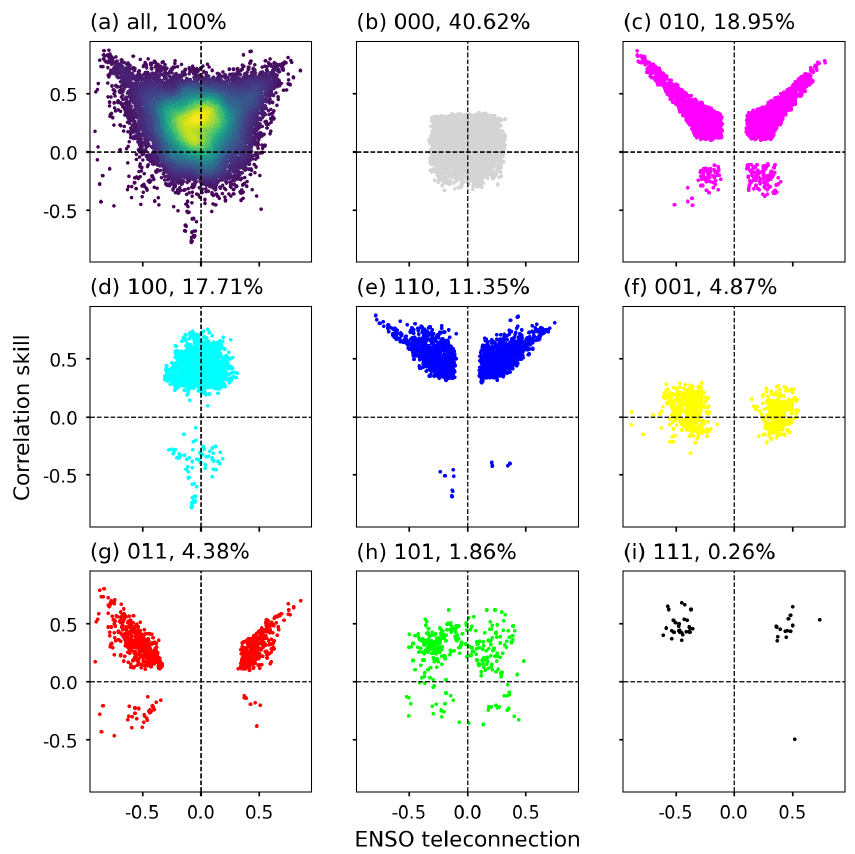
Figure 13. Scatter plots of the association of GCM forecast correlation skill with ENSO teleconnection at the global scale with the heatmap indicating the density of scatter points (a) and of the association of correlation skill with ENSO teleconnection under the eight patterns (b–i) .